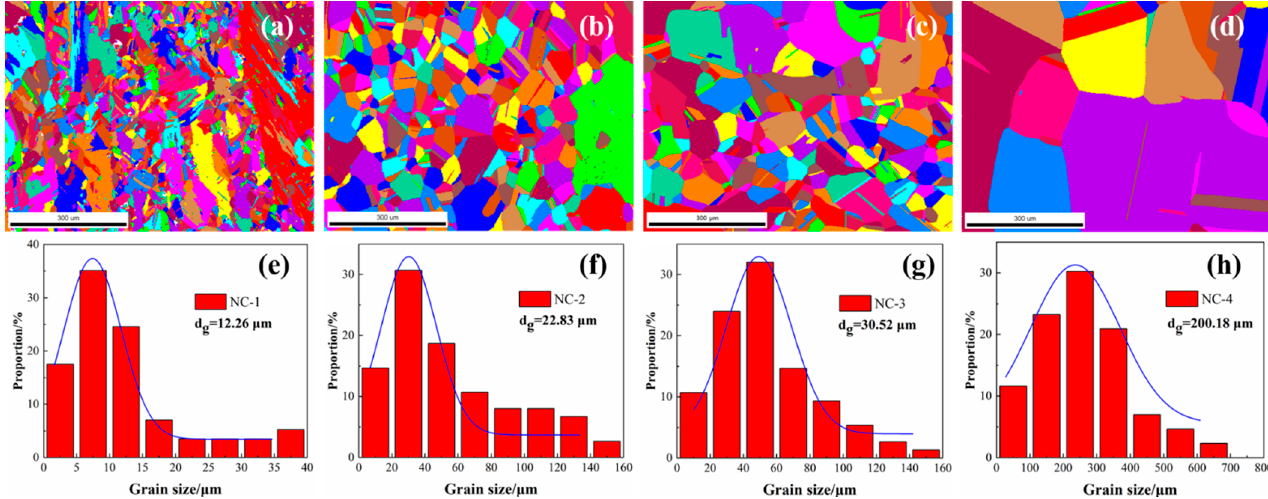
Figure 3. Microstructural characteristics and grain size of the tested alloys at the peak aging state. ( a , e ) NC-1 alloy; ( b , f ) NC-2 alloy; ( c , g ) NC-3 alloy; ( d , h ) NC-4 alloy.